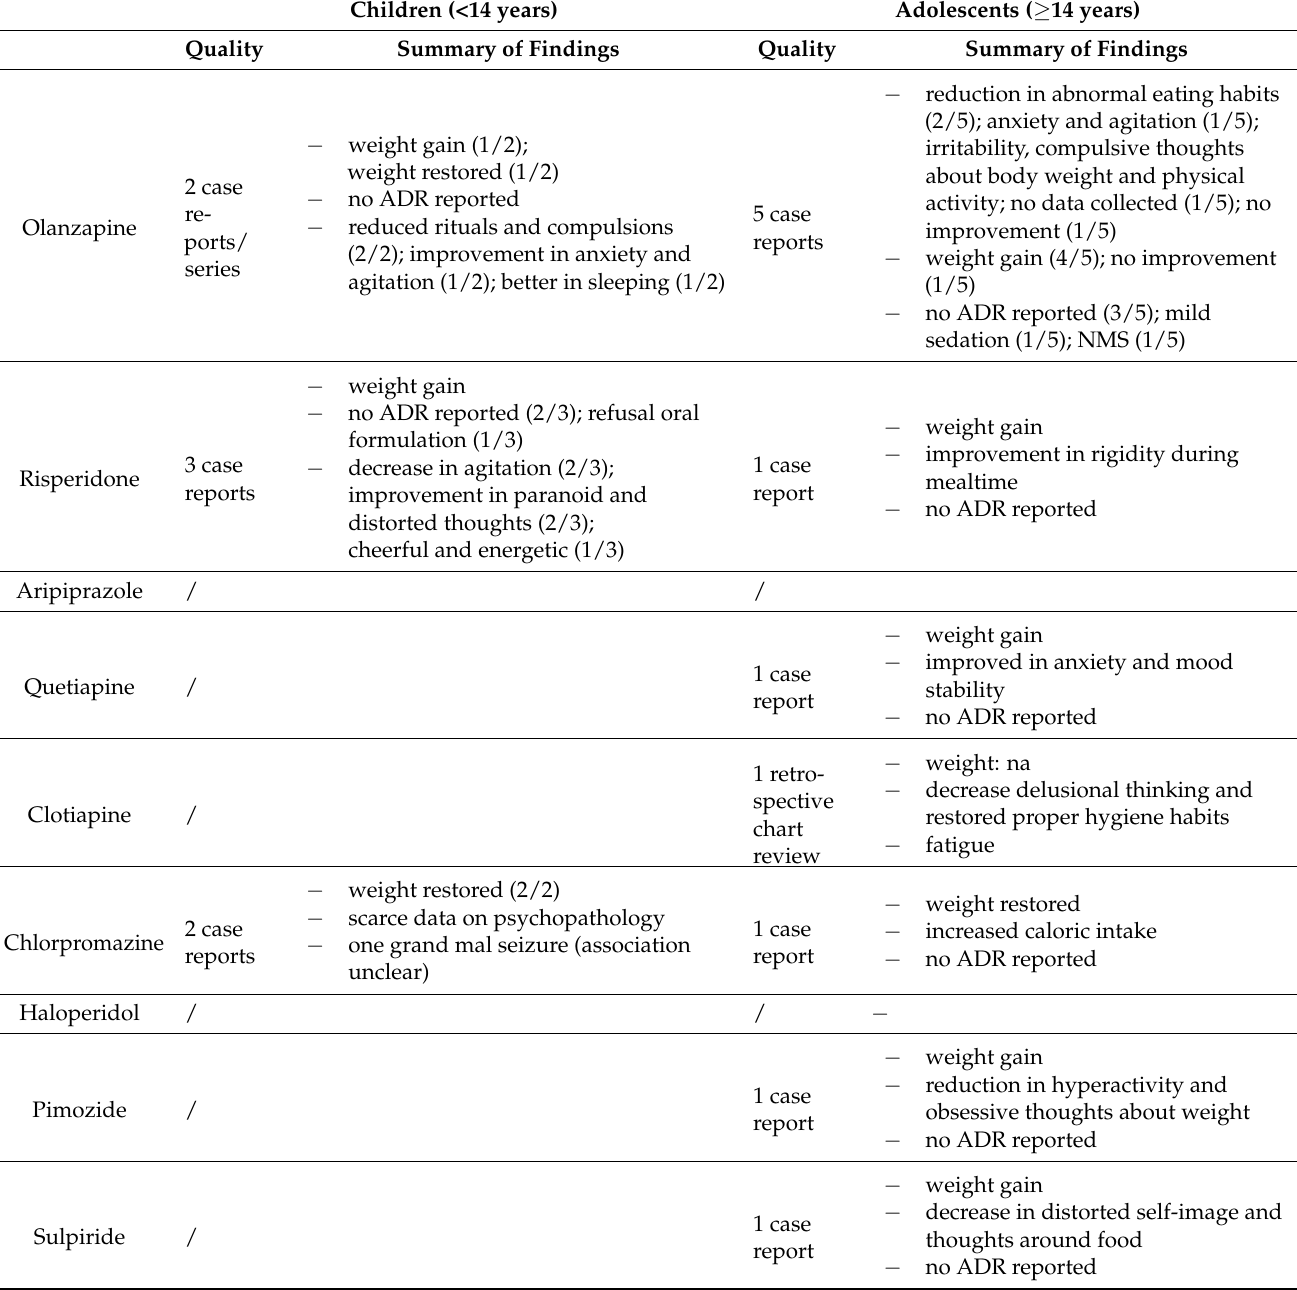
Table 4. Available evidence for age